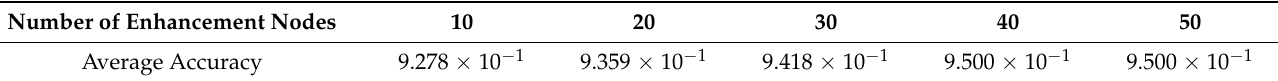
Table 3. Effect of population size on prediction accuracy.